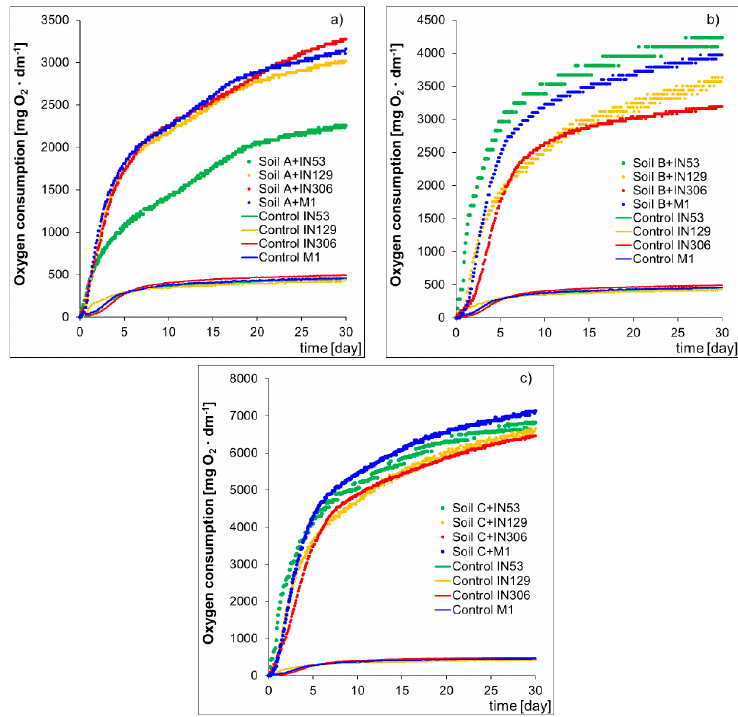
Figure 2. Oxygen consumption by microorganisms Mycolicibacterium frederiksbergense IN53, Rhodococcus erythropolis IN129, Rhodococcus sp. IN306 and mixed culture M1 to degrade ( a ) PCBs (sterile Soil A contaminated PCB), ( b ) TPH (sterile Soil B contaminated TPH), and ( c ) PCBs and TPH (sterile Soil C contaminated PCB and TPH) in the biodegradation process. Control-sterile uncontaminated “pure” soil inoculated with bacterial strains and mixed culture.